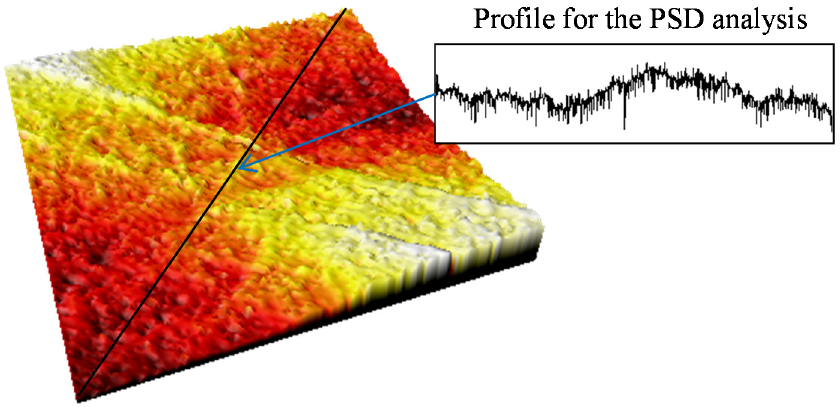
Figure 5. Surface topography in one of the measurement areas and the section profile used to calculate the irregularity factor.